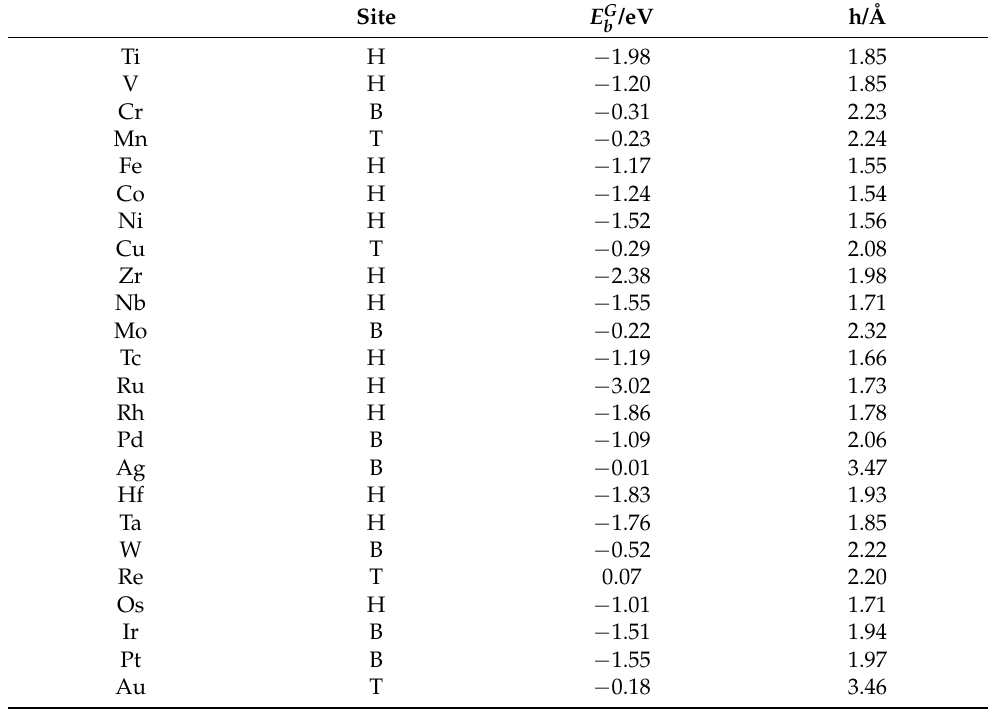
Table 1. The most stable adsorption site, binding energy ( E G of TM 1 − G